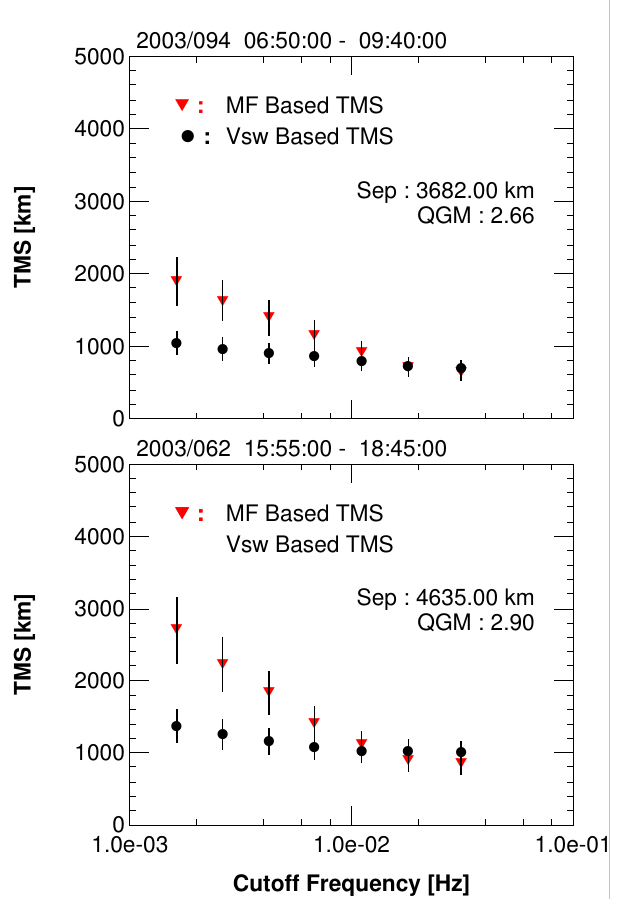
Fig. 8. Plots of the magnetic field and velocity based λ T as a function of cutoff frequency for two time intervals. The magnetic field based values increasingly separate from the velocity based values with increasing scale length (decreasing cutoff filter).